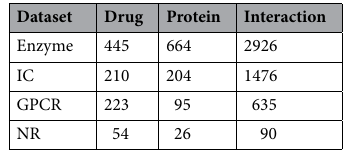
Table 2. Database information used in this article 35 .